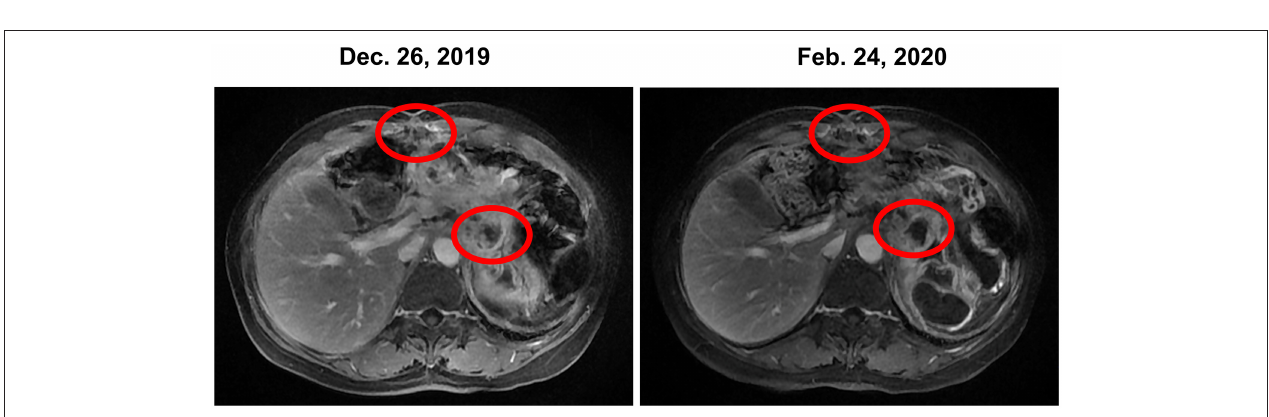
PALB2 has been identified as one of the major known susceptibility genes for pancreatic cancer (9). The germline mutation of PALB2, a significant gene in regulating homologous